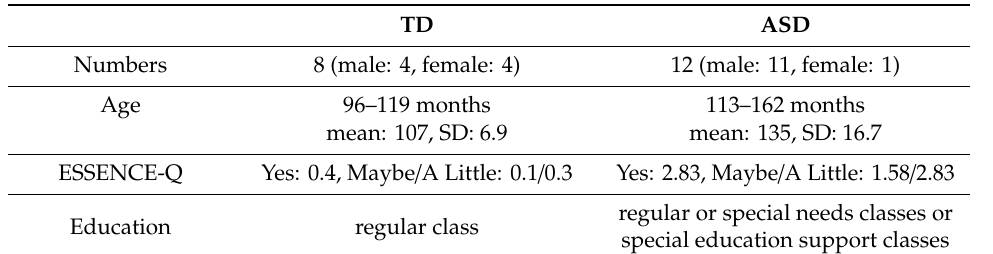
Table 1. Age, mean scores of Early Symptomatic Syndromes Eliciting Neurodevelopmental Clinical Examinations-Questionnaire (ESSENCE-Q) and education for each group of